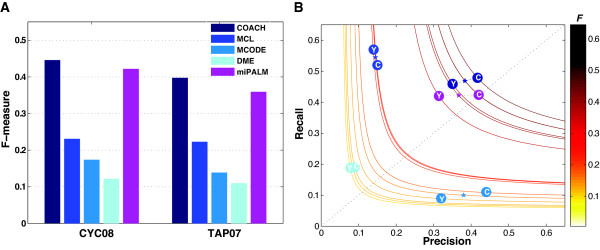
Performance comparison of five complex detection algorithms. A) F-measure of the five algorithms with their best parameters optimized to two sets of known complexes CYC08 and YHTP08 using the DIP network as input. B) Precision and recall of the methods. Circles, F-measures measured against CYC08 (C) or YHTP08 (Y). Lines, F-measure contours. Two different points on the precision-recall plane can have the same F-measure values if they lie on the same F-measure iso-line. The average F-measure of an algorithm, over the two gold standard sets, is indicated with a star.